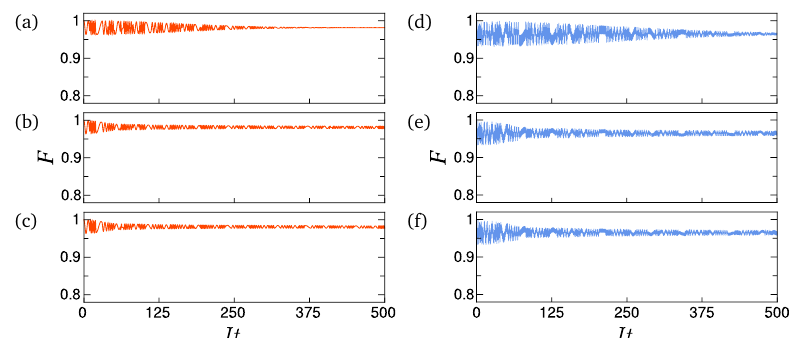
Figure 9: Fidelity as a function of time. Left panels: U = 0.17 and l = 0, for N = 60 and initial states (a) : | 60,0,0 〉 , (b) : | 40,0,20 〉 and (c) : | 30,0,30 〉 . Right panels: U = 0.7 and l = 9, for N = 60 and initial states (d) : | 51,9,0 〉 , (e) : | 36,9,15 〉 and (f) : | 26,9,25 〉